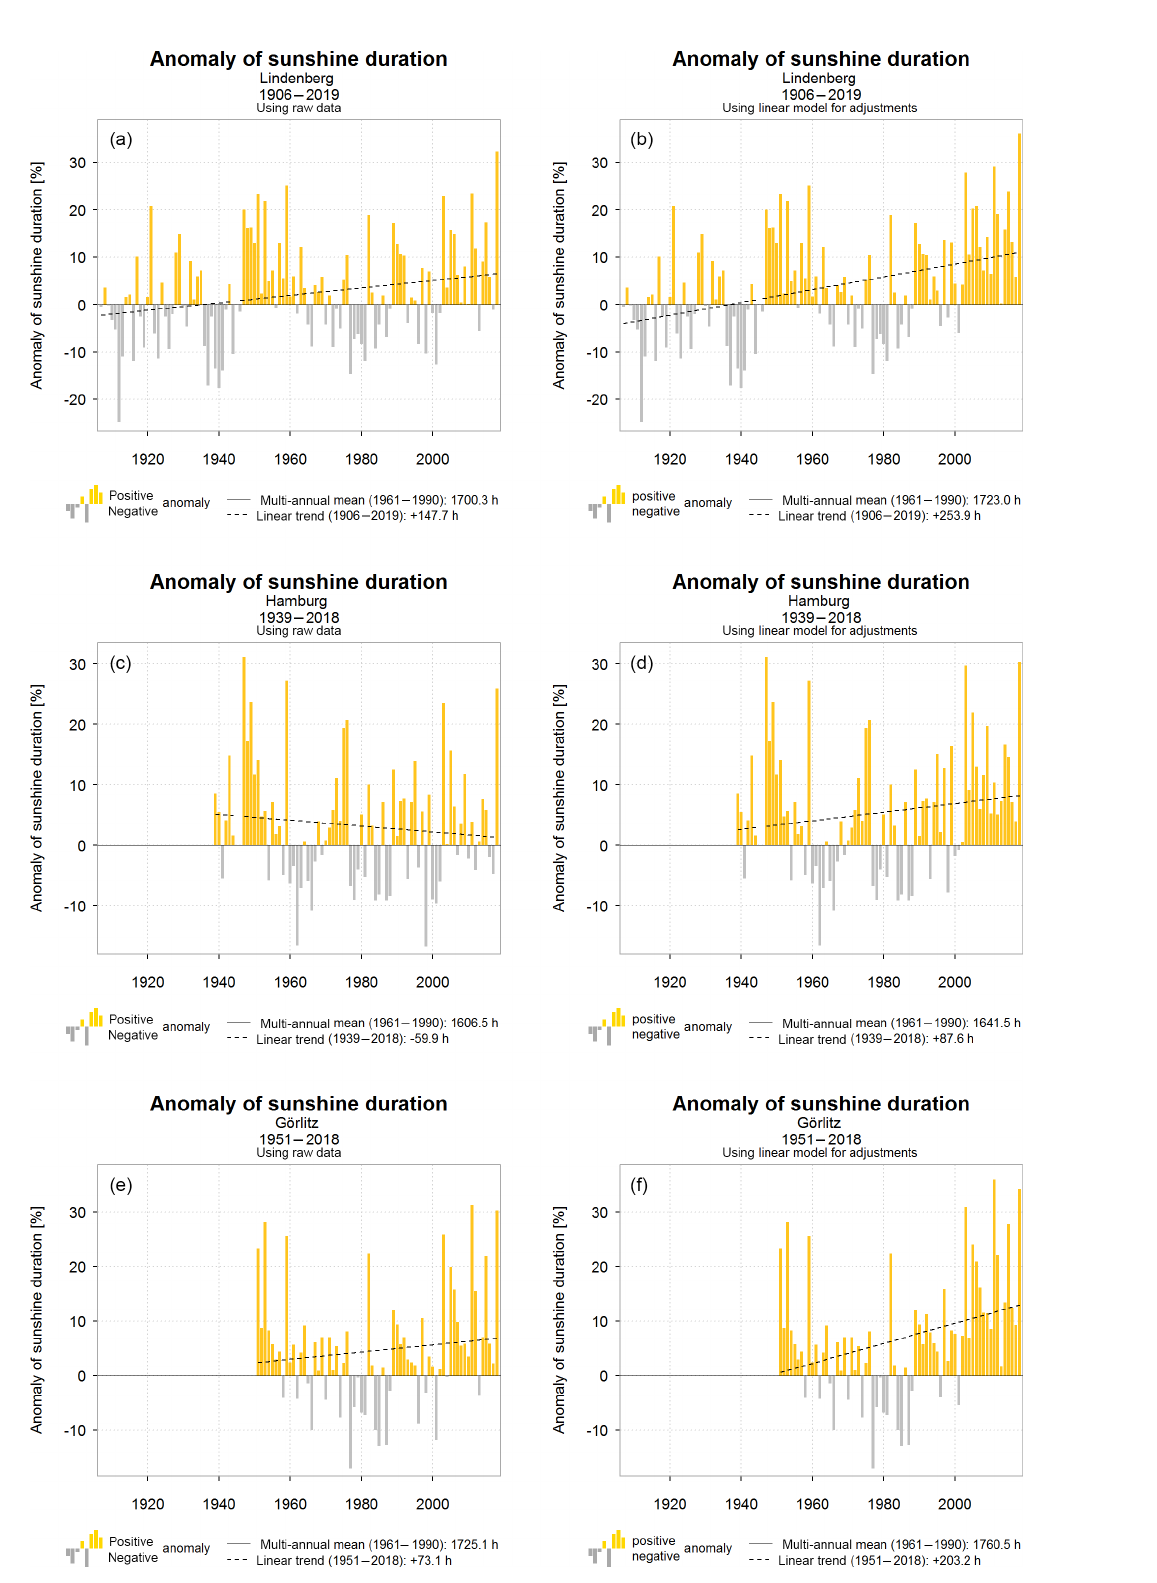
Figure 10. Anomaly of sunshine duration using raw data (a, c, e) and using the linear regression model to adjust the automatic measure- ments (b, d, f)